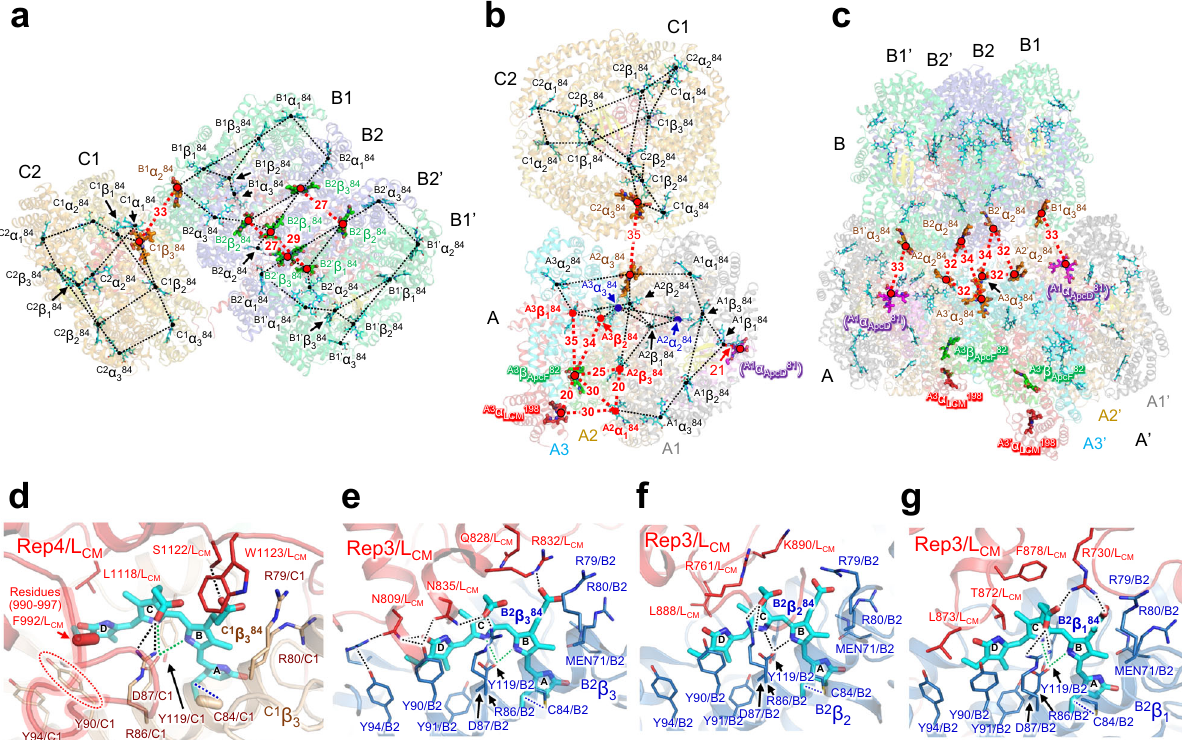
Fig. 3 Arrangement of chromophores is the key to the energy transfer pathway in PBS core. a Possible energy transfer pathways in and between B and C (C ’ ) cylinders. b Possible energy transfer pathways in and between A and C cylinders. c Possible energy transfer pathways between A (A ’ ) and B cylinders. d – g The chromophores and the surrounding amino acid residues of ApcE (L CM ). The numbers near the dotted lines indicate the distances (Å) between the PCB pairs. In e – g , dashed lines (black and green) indicate hydrogen bonds, and dotted lines (blue) indicate covalent bonds between PCB and cysteine residue. In the amino acid residues (Phe992/ApcE and Cys84/C1) in d , the directions of atoms from C α to C β in the residues are indicated by the capsule- shaped objects. The identi fi cation of ApcD is tentative, and the chromophore in ApcD ( A1 α ApcD 81 ) is indicated in